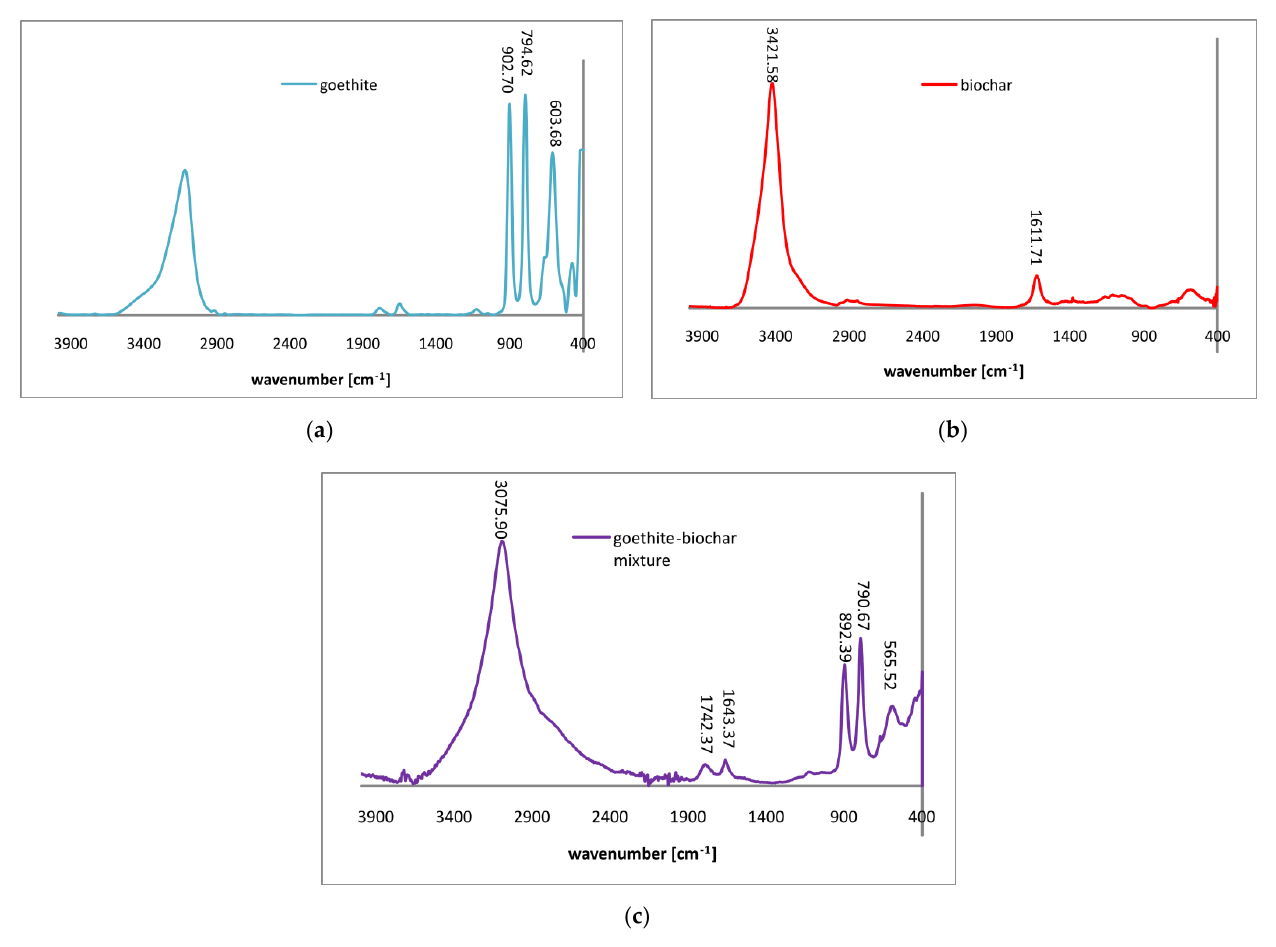
Figure 2. FTIR spectra for goethite ( a ), biochar ( b ) and goethite–biochar mixture ( c ). The spectrum of goethite consisted of the following bands at: 3109.06 cm −1 (corre- Table 2. O1s XPS data obtained for goethite and